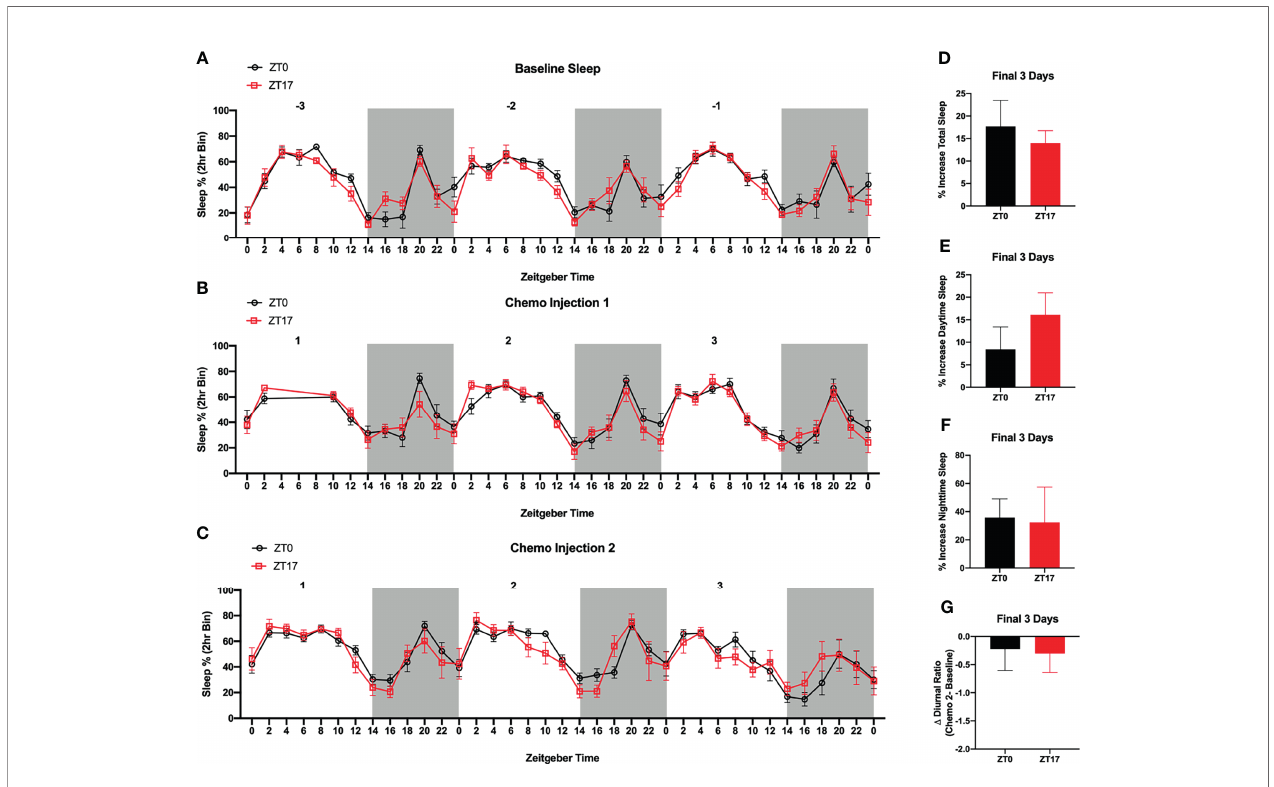
FIGURE 4 | Timing of Paclitaxel Administration Does Not Alter Sleep/Wake States in Mice Harboring JIMT-1BR3 BMBC. Sleep/Wake states did not signi fi cantly differ between (A) baseline, (B) three days following the fi rst paclitaxel injection, or (C) three days following the second paclitaxel injection. There was an unexpected power outage following the fi rst paclitaxel injection, day 1 ZT4-8. Additionally, whereas in both groups there was an increase in (D) total sleep, (E) sleep during the daytime, and (F) sleep during the nighttime in the three days following the second paclitaxel injection relative to baseline sleep, these effects were not speci fi c to one group. Further, there was no change in the (G) diurnal ratio between groups. (A – C) . n= 8,7 respectively; (D – F) . n= 8,6 respectively; (G) n=7,5 respectively). The data are presented as mean +SEM. (A, B) Two-way repeated measures ANOVA; Fisher ’ s LSD multiple comparisons test. (C) Mixed effect analysis; Fisher ’ s LSD multiple comparisons test. (D – G) unpaired t